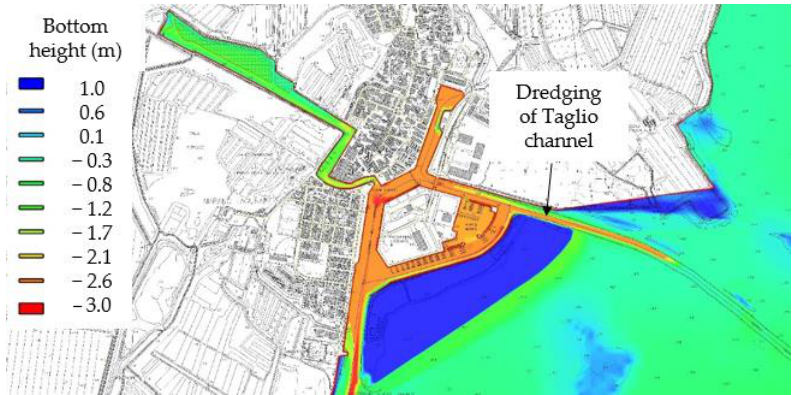
Figure 15. Bottom height of the new configuration, supposing a dredged Taglio channel.